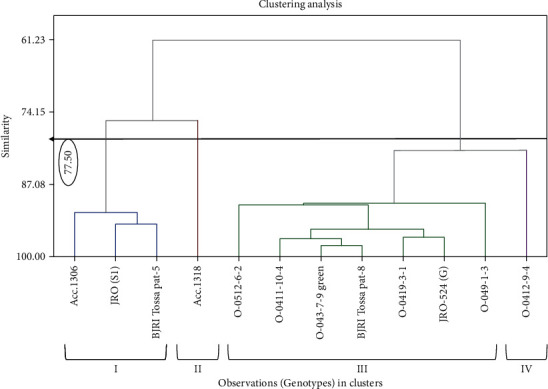
Dendrogram showing the relationships among 12 tossa jute genotypes for six anatomical characters contributing to fiber yield.